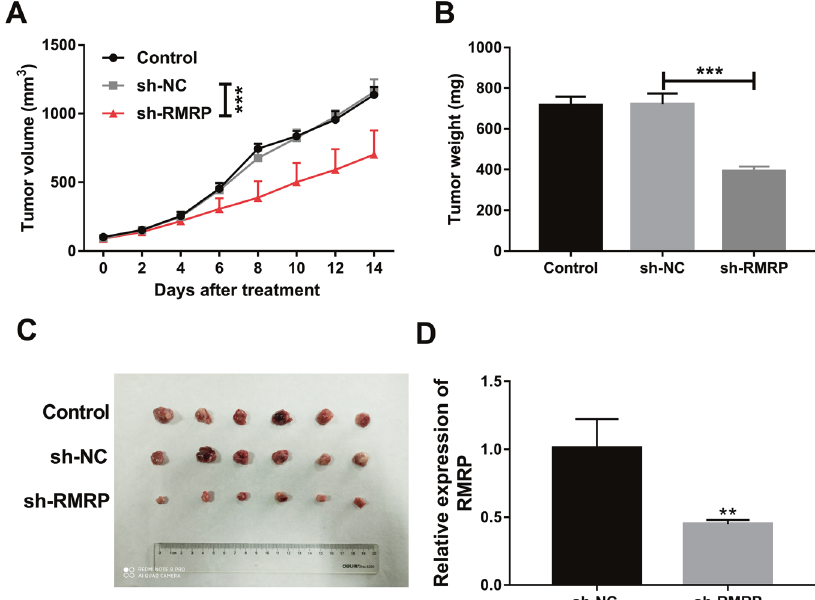
Fig. 3 Effects of RMRP knockdown on the growth of TMZ-treated glioma xenograft tumors. A The volumes of xenograft tumors were measured every 2 days after TMZ treatment. B Tumor weight was determined on day 14 after TMZ treatment. C Representative photographs of xenograft tumors in control, sh-NC, and sh-RMRP groups. D RMRP level was measured by RT-qPCR assay in xenograft tumors of sh-NC and sh-RMRP groups. Each group contains 6 mice. ** P < 0.01. *** P <